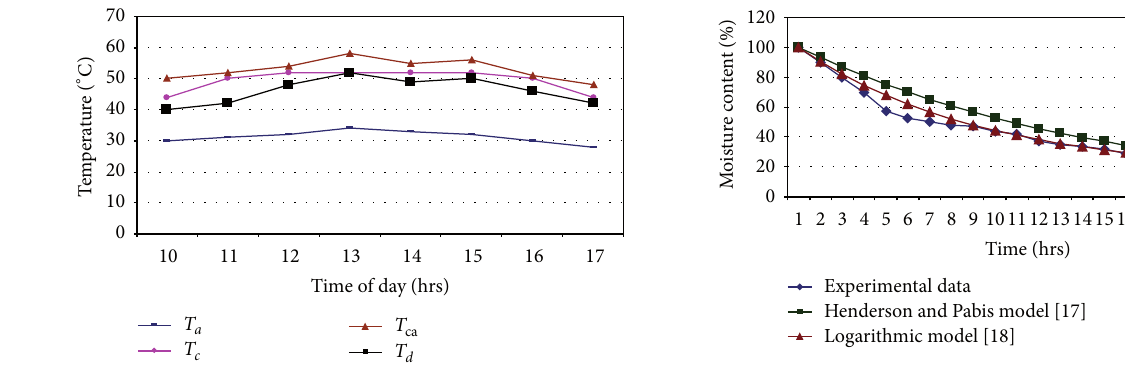
Figure6:Percentagemoisturecontentremovalinthedriedplantain fillet compared with two drying